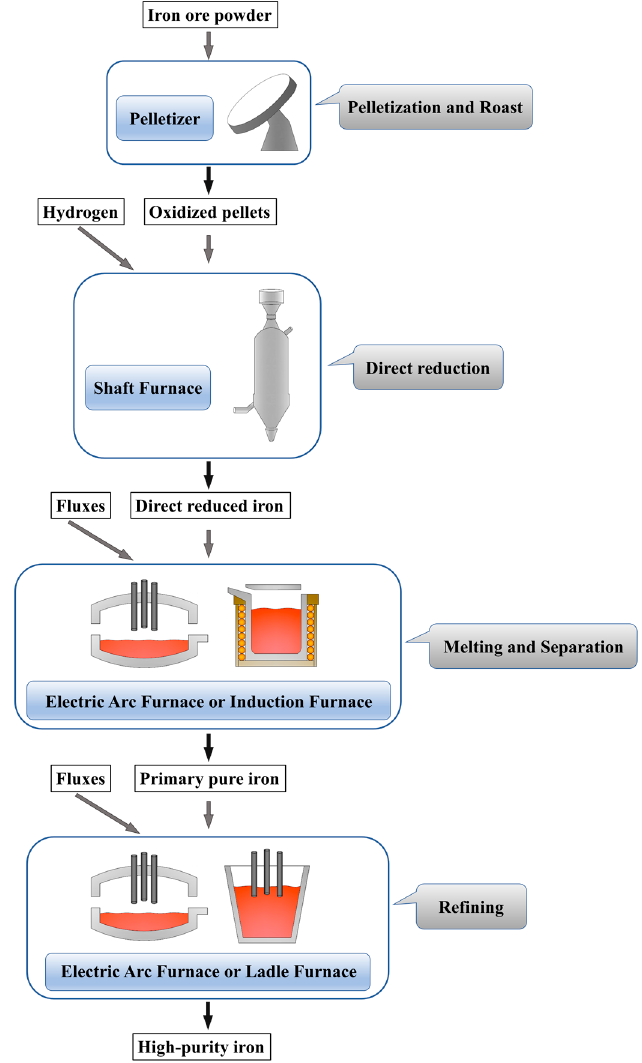
Figure 9. The approach proposed in this study to produce high-purity iron.